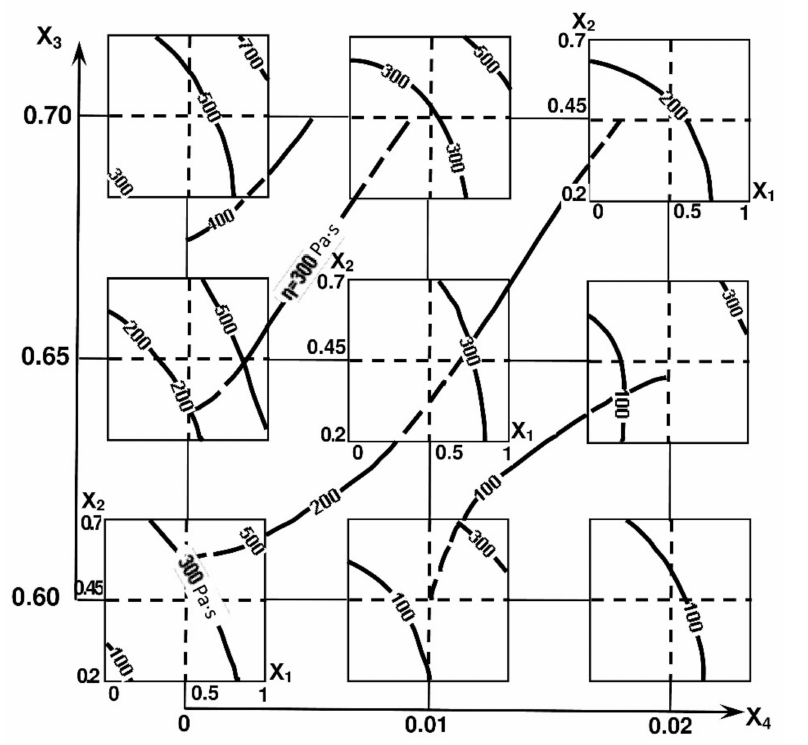
Figure 5. Isolines of cement-water pastes with AMAd viscosity. Table 4. Normal consistency of filled cement-water